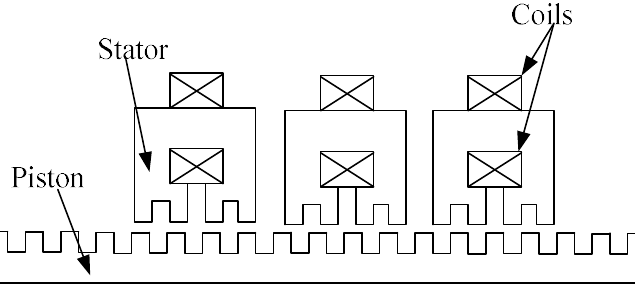
Figure 7. Sketch of the linear switched reluctance generator.